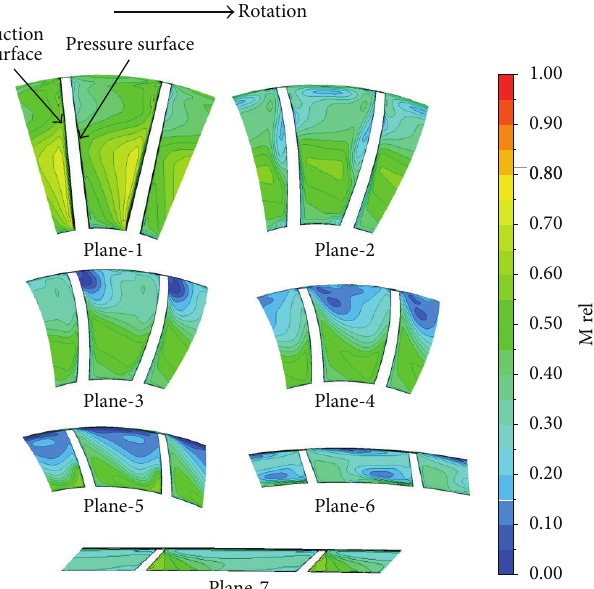
Figure 21: Relative Mach number distribution on streamwise planes of CT-1 impeller at stall mass flow rate.